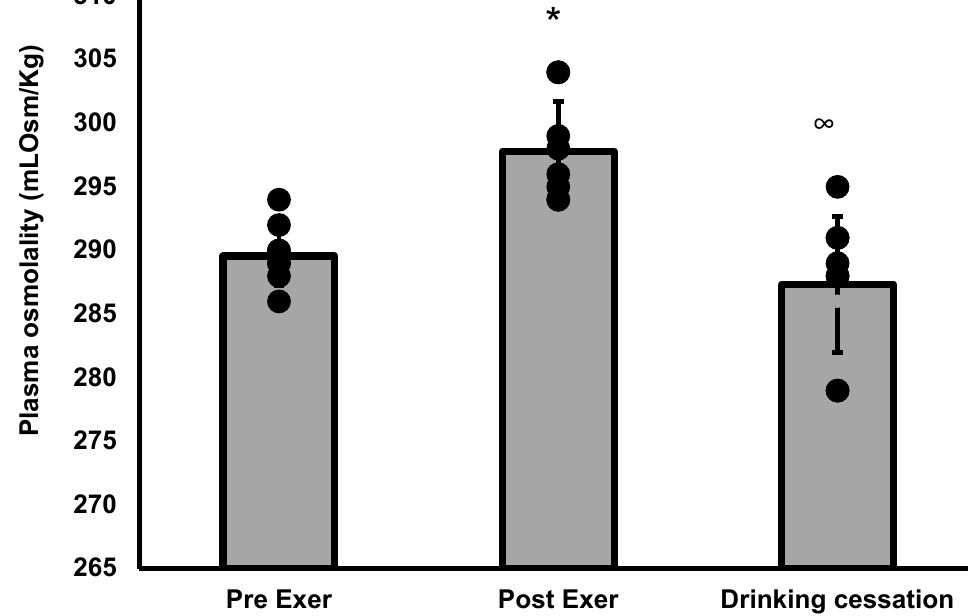
Figure 3. ANOVA analysis for plasma osmolality, * pre-exer vs. post-exer (dehydration) ( p = 0.0006), pre-exer vs. drinking cessation ( p = 0.524), ∞ post-exer (dehydration) vs. drinking cessation ( p < 0.0001). Bar height represents average values; dots represent individual plasma